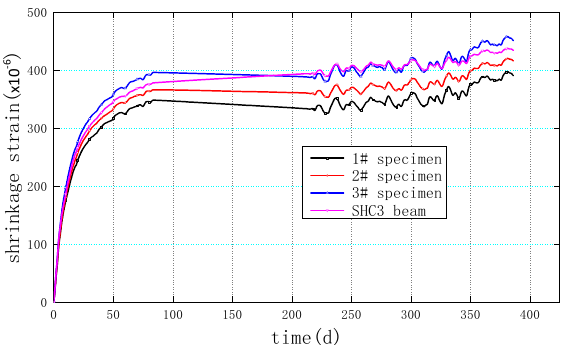
Figure 6. Time ‐ history plots of the shrinkage strain of various T ‐ beam specimens (including tem ‐ perature and humidity effects).